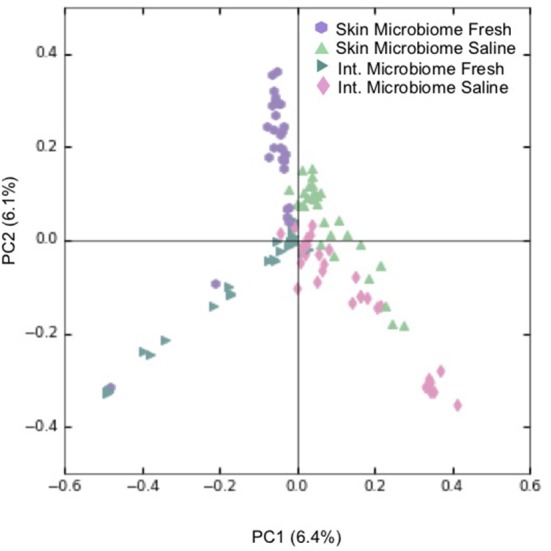
Principal coordinate analysis (PCoA) showing clustering of individual skin and intestinal microbiome communities based on Bray-Curtis dissimilarity. For every skin-associated community represented, a counterpart intestine-associated community from the same S. alpinus individual is shown. Legend refers to the sample type and environment of where an S. alpinus individual was caught and includes skin microbiomes from freshwater sites (n = 30), and from saline sites (n = 30), as well as intestinal microbiomes from freshwater sites (n = 30) and from saline sites (n = 30). Fresh refers to lake and river sites sampled in winter and spring while saline refers to sea shoreline locations sampled in autumn during the annual char run.